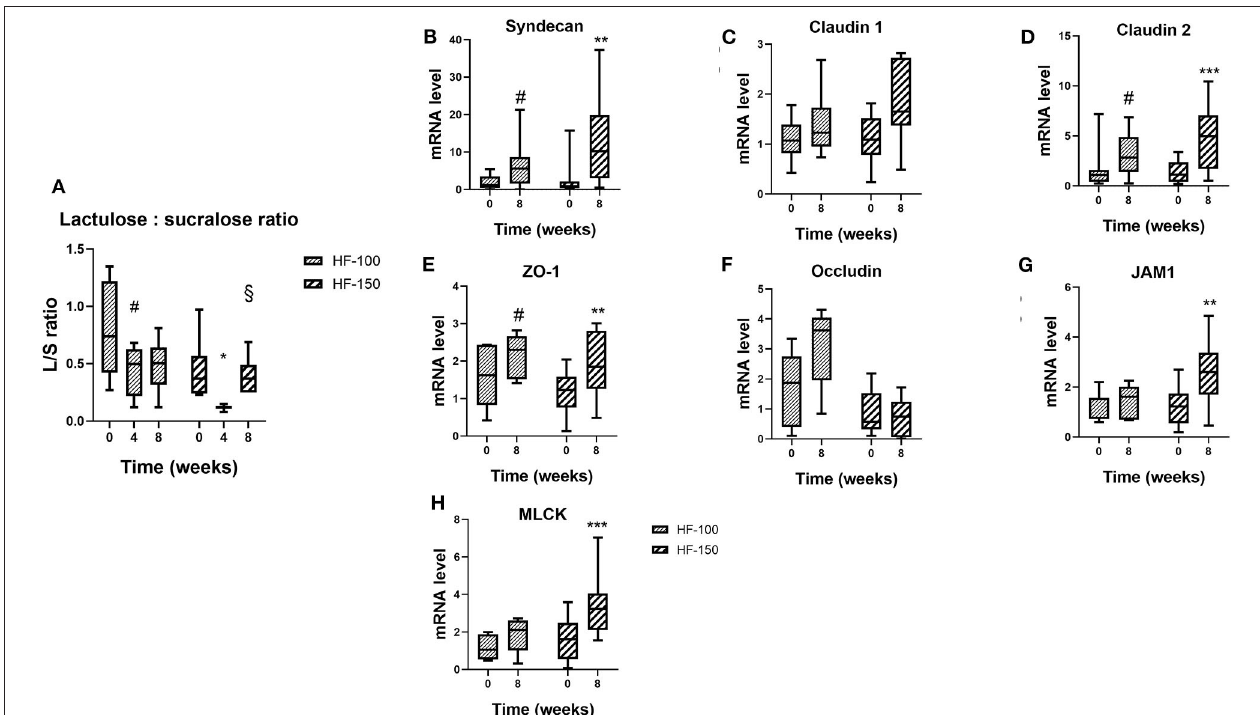
FIGURE 6 | (A) Lactulose:sucralose ratio in urine after an oral administration and (B) Syndecan, (C) Claudin-2, (D) ZO-1, (E) Junctional adhesion molecule 1 (JAM1), (F) Myosin light-chain kinase (MLCK), (G) Claudin-1, and (H) Occludin mRNA levels in dogs fed the high-fat diet at maintenance (HF-100; n = 8) and at 150% maintenance (HF-150; n = 16) for 8 weeks. Data are median (range min-max). * P < 0.05, ** P < 0.01, *** P < 0.001 at weeks 4 and 8 vs. week 0 for HF-150 group, § P < 0.05 at week 8 vs. week 4 for HF-150 group, # P < 0.05 at weeks 4 and 8 vs. week 0 for HF-100 group.